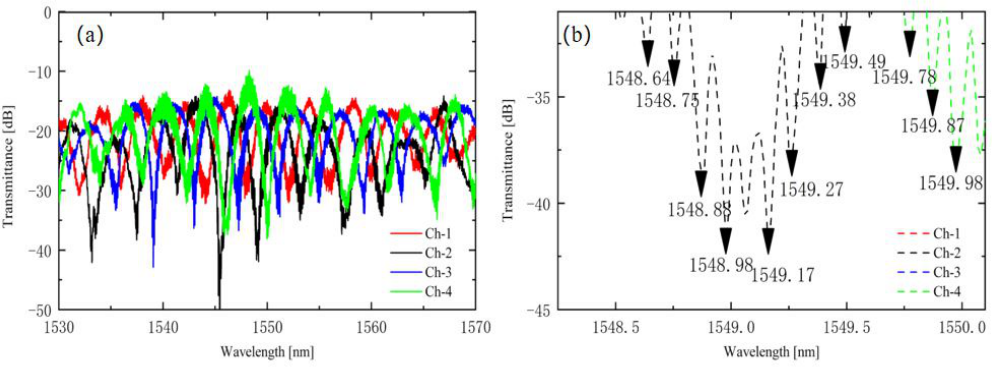
Figure 12. ( a ) Transmission spectra of the fabricated 90° hybrid, and ( b ) weak oscillation of the transmission spectra.